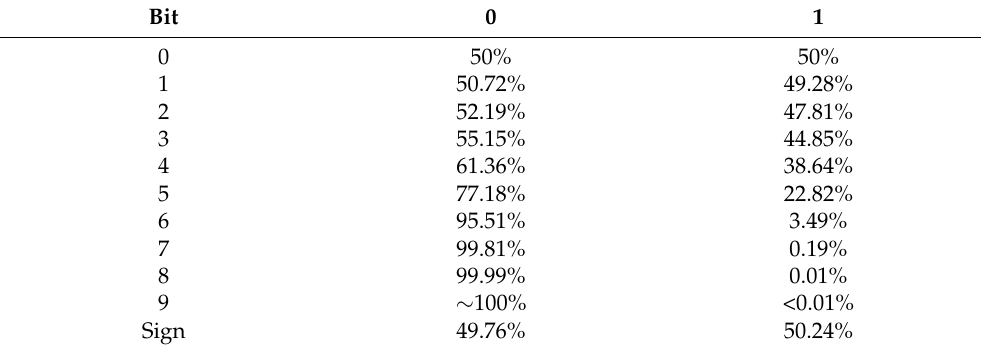
Table 1. Frequency of each bit of a delta-coded sample signal having a value of ‘0’ or ‘1’ when taken as an absolute value. Bits 9 to 14 are not shown as their probability being ‘1’ is exponentially reduced each step. For the Signal bit, only nonzero values were counted, with ‘0’ meaning a positive signal and ‘1’ negative.